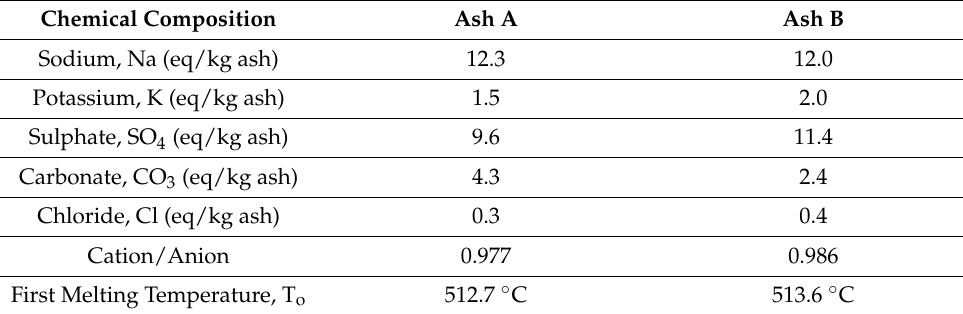
Table 1. Chemical analysis of Ash A and Ash B.